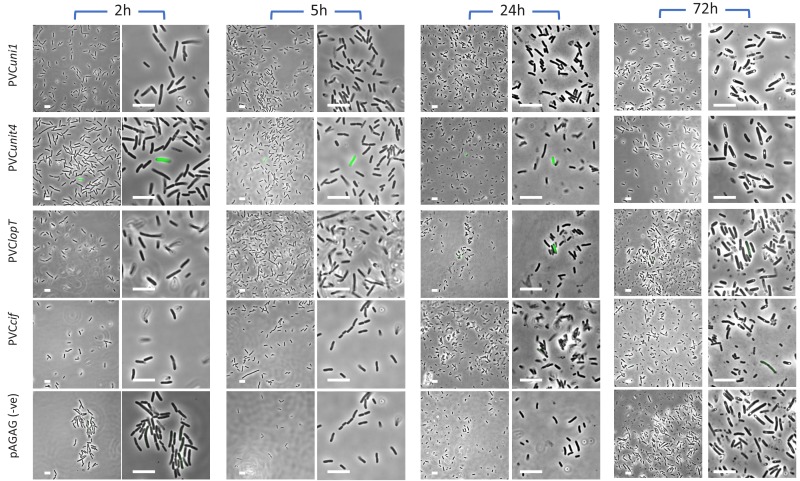
A representative selection of images for four growth time points, for P. luminescens.TT01 harbouring four different pvc-operon reporter constructs and the pAGAG negative control reporter plasmid containing no promoter. Wide field (left) and a magnified subsection (right) panels are shown for each timepoint.